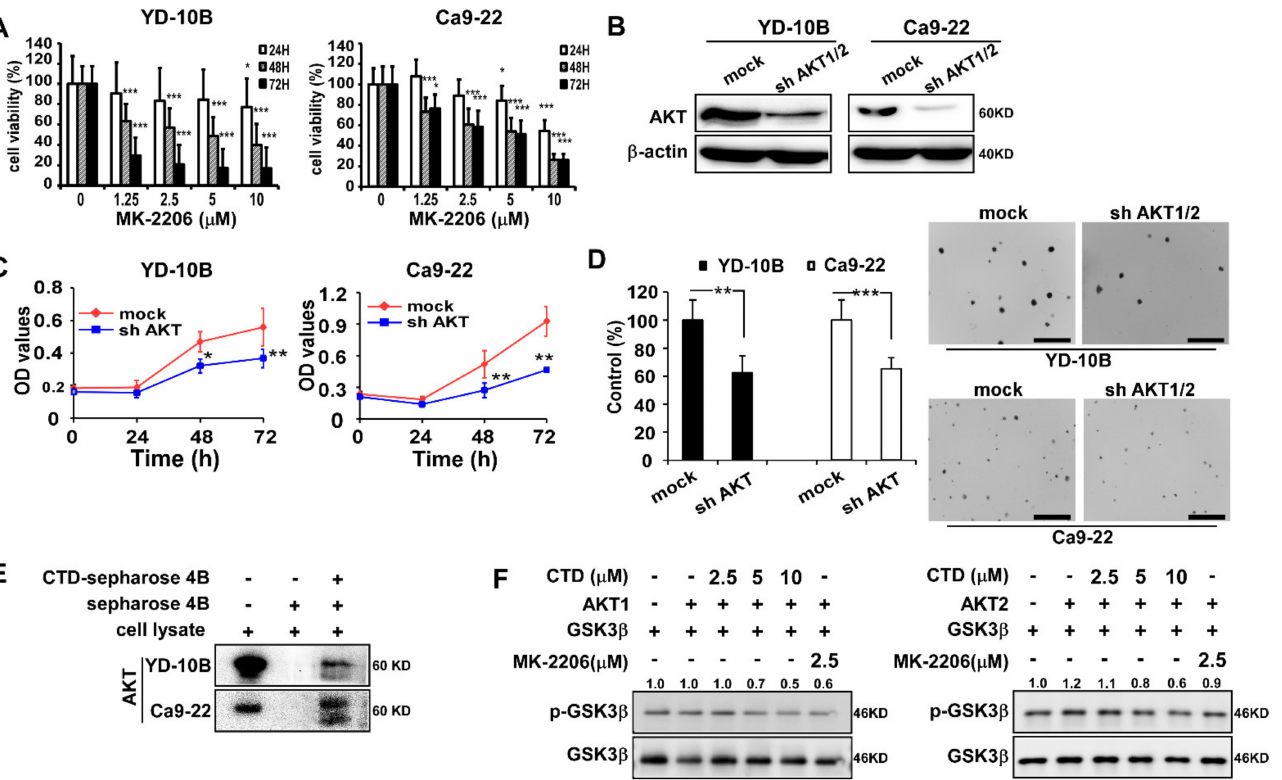
Figure 2. AKT is a target of Costunolide. ( A ) The proliferation of OC cells under the AKT inhibitor (MK-2206) was determined by the MTT assay at 24, 48 and 72 h. ( B ) AKT expression was detected by the western blot assay after knockdown of AKT in oral cancer cells. ( C ) Cell growth was examined in oral cancer cells after knockdown of AKT by the CCK-8 assay. ( D ) Anchorage-independent growth was evaluated in oral cancer cells after knockdown of AKT (Scale bar = 200 µ m). Data are represented as mean ± SD of values from triplicate samples. * p < 0.05, ** p < 0.01 and *** p < 0.001 indicate a significant difference compared with control. ( E ) Costunolide binds with AKT. ( F ) The AKT kinase activity was inhibited by costunolide and downregulated the phosphorylation of GSK3 β , the AKT